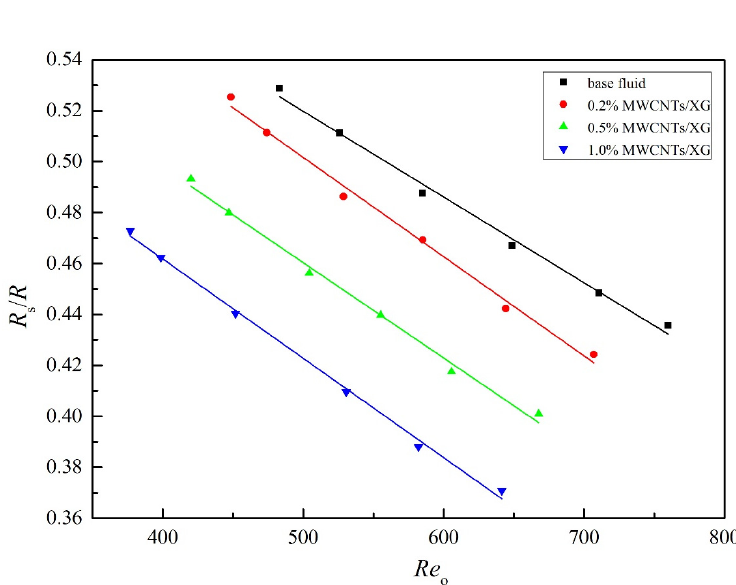
Figure 8. Ratio of shell side thermal resistance to overall thermal resistance at different shell-side Reynolds number.